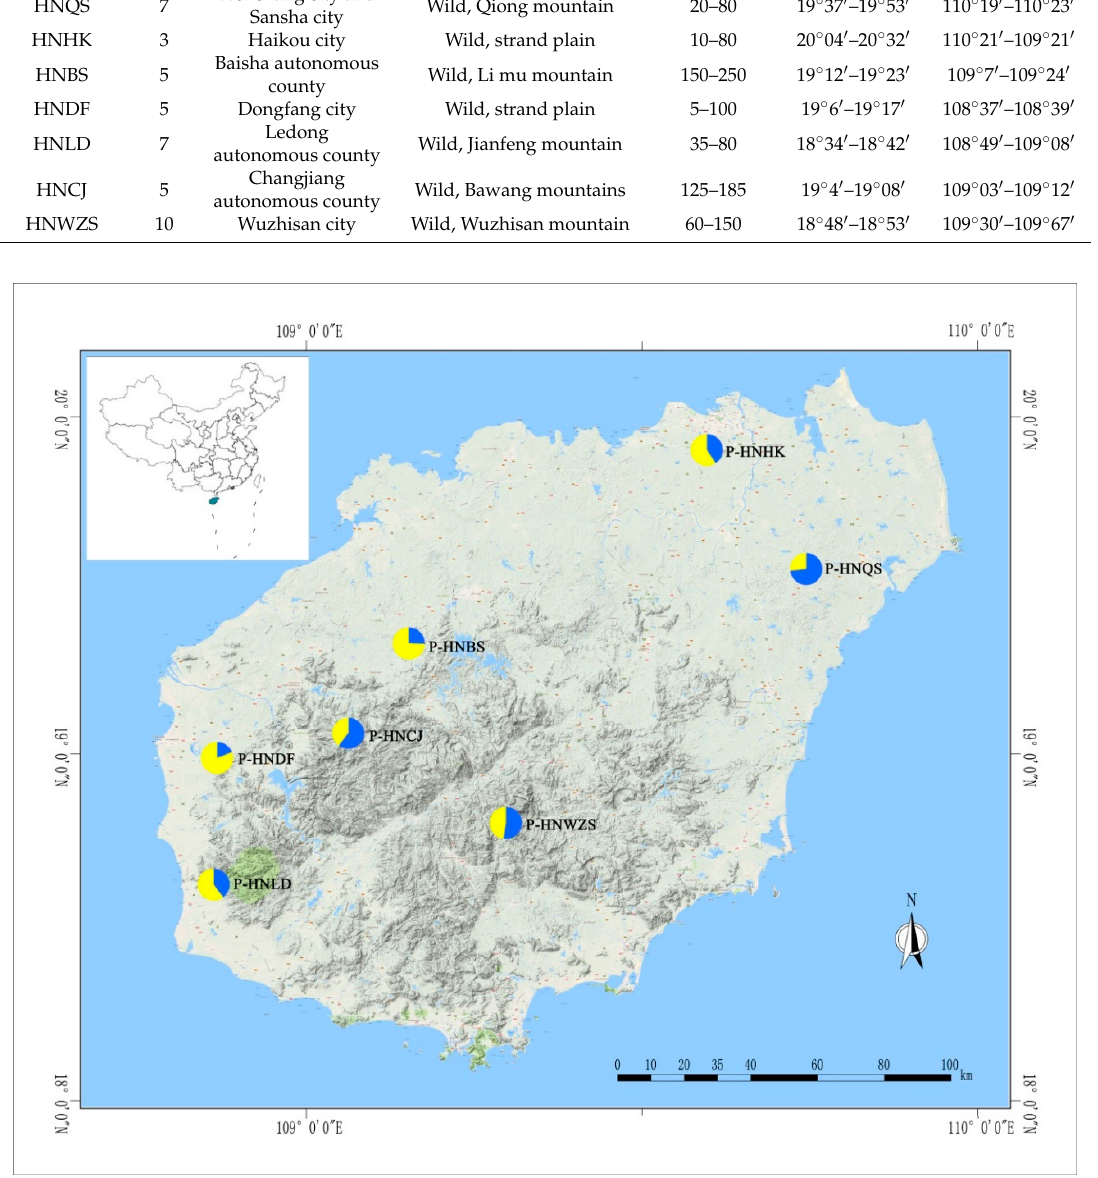
Figure 1. Geographic location of seven investigated D. odorifera populations collected from Hainan Island in China. P-HNQS—population of Wenchang city and Sansha city in Hainan province, P-HNHK—population of Haikou city, P-HNBS—population of Baisha city, P-HNDF—population of Dongfang city, P-HNLD—population of Ledong autonomous county, P-HNCJ—population of Changjiang autonomous county, P-HNWZS—population of Wuzhisan city. The pie charts estimated genetic structure of the seven populations based on STRUCTURE analysis with cluster number of two, in each chart, different color represents a different cluster accounted in each population.